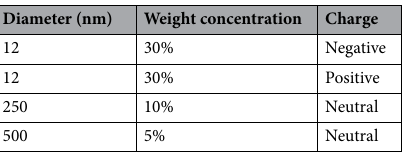
Table 1. The vSiO 2 nanoparticles in the various aqueous suspensions considered in this work.